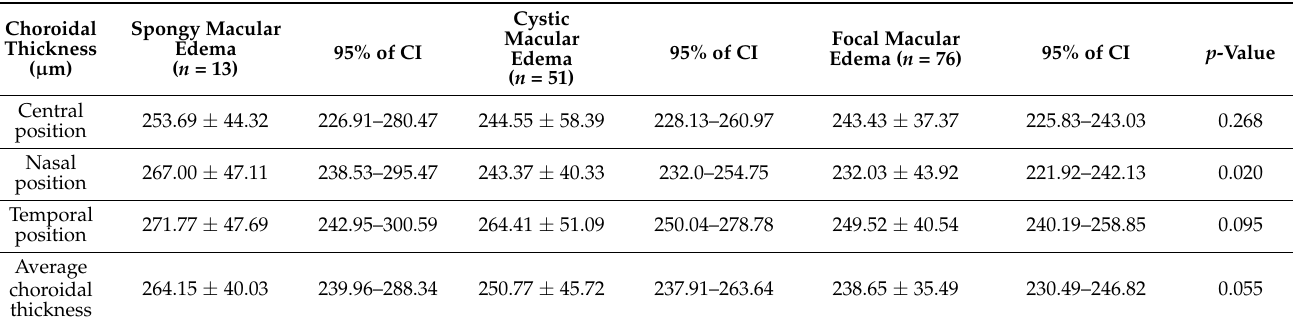
Figure 5. Measurement of choroidal thickness using the proposed in this work for segmentation of the retina and choroid layer. ( a ) Focal macular edema (FME). ( b ) Spongy macular edema (SME). ( c ) Cystic macular edema (CME). ( d ) CME with subretinal fluid (CME+). ( e ) Comparison of choroid thickness between normal, FME, SNE, and CME at different locations (SF, N, and T) and average choroid thickness. ( f ) Comparison of choroid thickness between normal and FME and Diffuse included SME and CME groups. ( g ) Comparison of choroid thickness between CME and CME+. Table 1. Comparison of choroidal thickness measurements (by manual method) between spongy macular edema, cystic macular edema, and focal macular